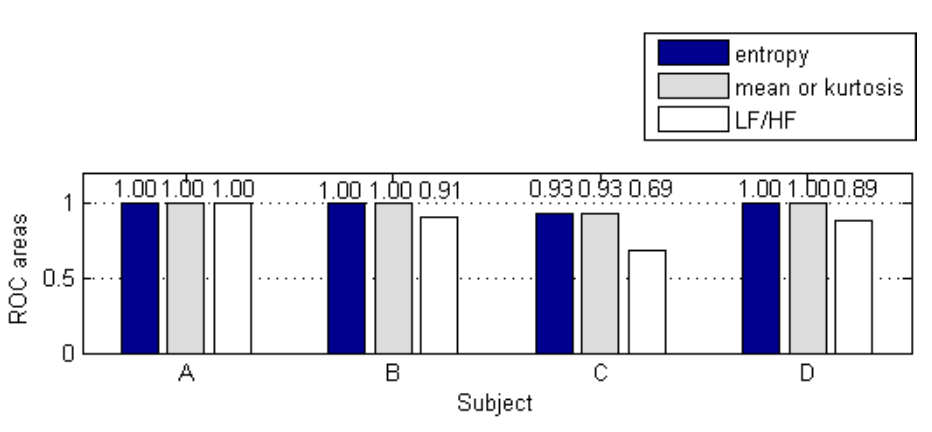
Figure 9. Comparison of LF/HF and wavelet-based features based on standard HRV